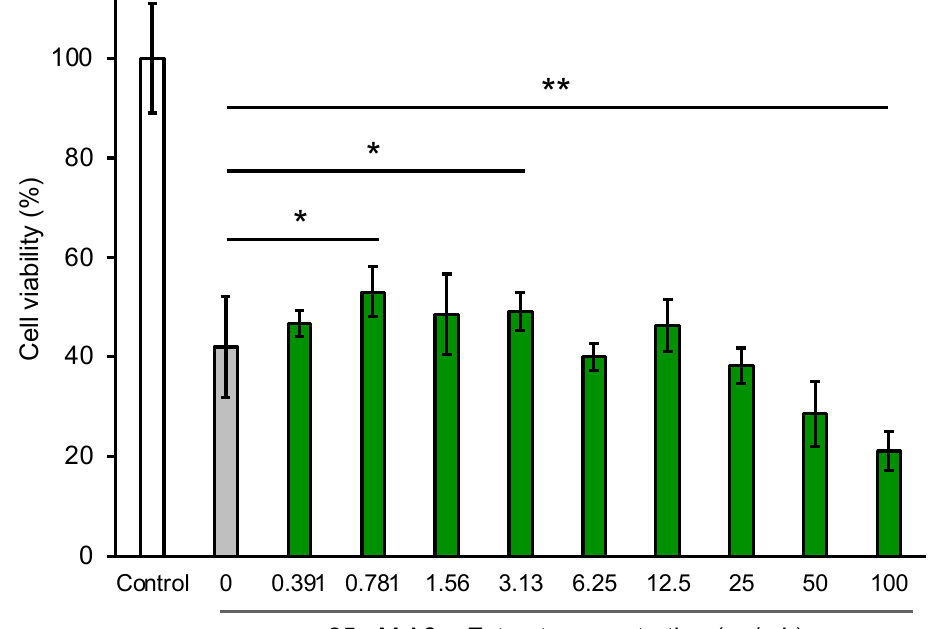
Figure 9. Extracts from Perilla frutescens var. crispa leaves suppressed A β -induced cytotoxicity in NGF-differentiated PC12 cells. PC12 cells were differentiated by NGF for 24 h and treated with 25 µ M A β 42 and leaf extract for 24 h. Cell viability was measured by the MTT assay and shown as the relative percentage of absorbance of treated samples compared to the control without A β and extract. Each plot and bar graph represent the mean ± SD ( n = 3 separate experiments with extracts, 6 separate experiments in control, and 25 µ M A β only). Comparison of the values (*: p < 0.05, **: p < 0.01, Welch’s t -test).